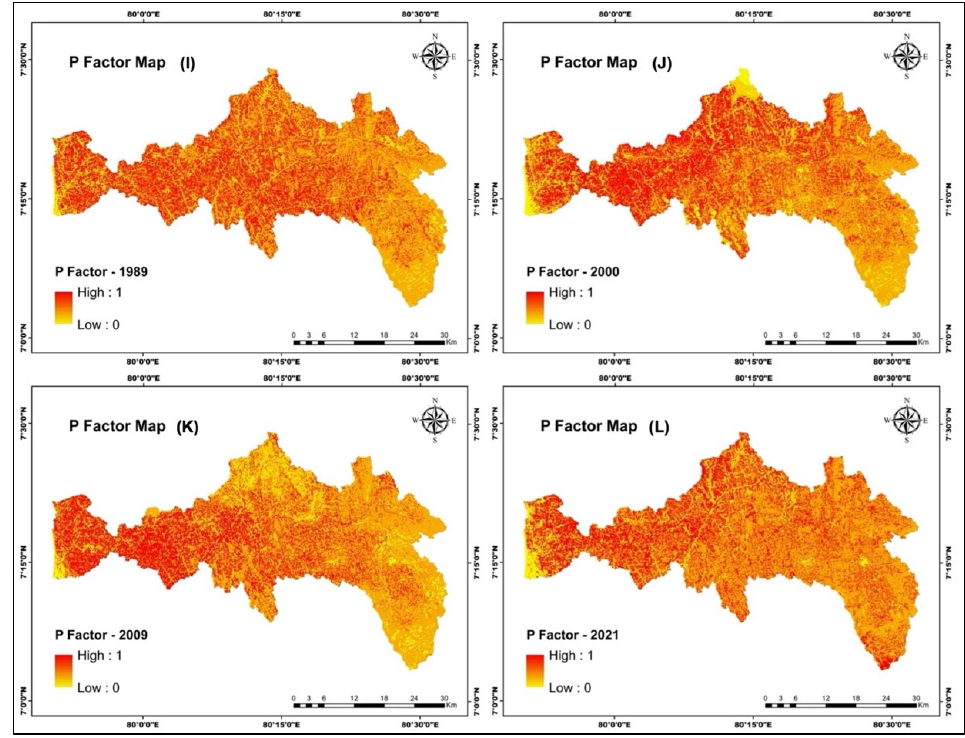
Figure A3. P factor maps of the study area for corresponding years: ( I ) 1989, ( J ) 2000, ( K ) 2009, ( L ) 2021.